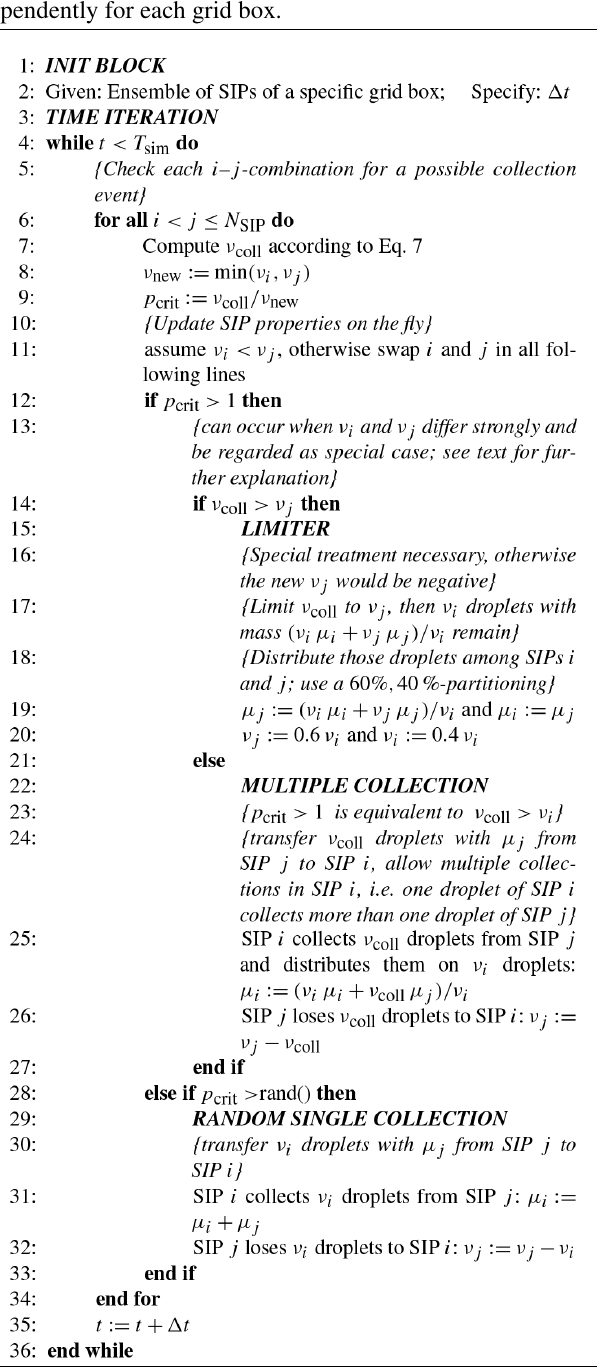
Algorithm 1 Pseudo-code of the regular